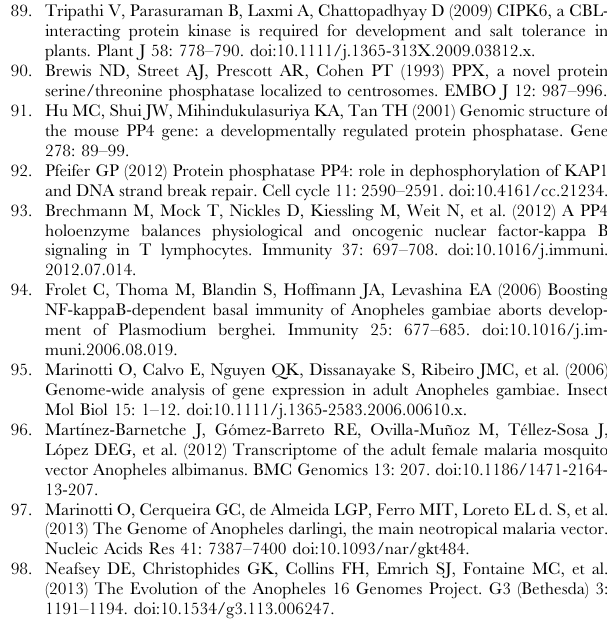
(2013) The Evolution of the Anopheles 16 Genomes Project. G3 (Bethesda) 3: 1191–1194.